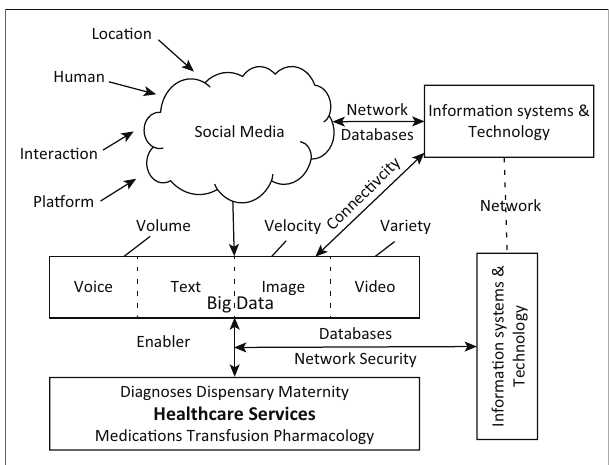
FIGURE 2: Information technology integration of social media with healthcare big